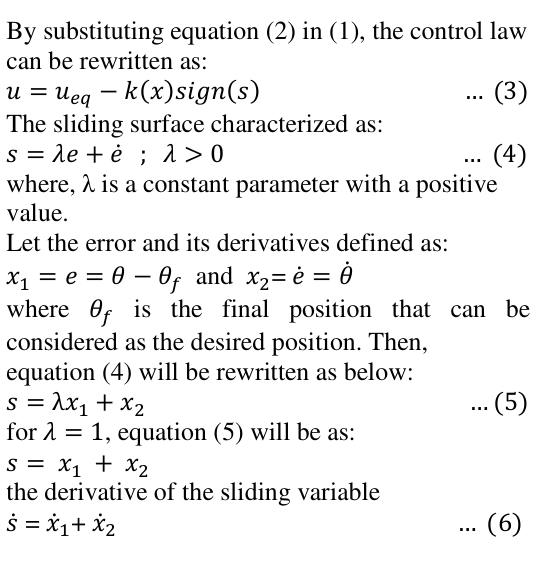
Fig. 1. The two phases of the sliding control [2].